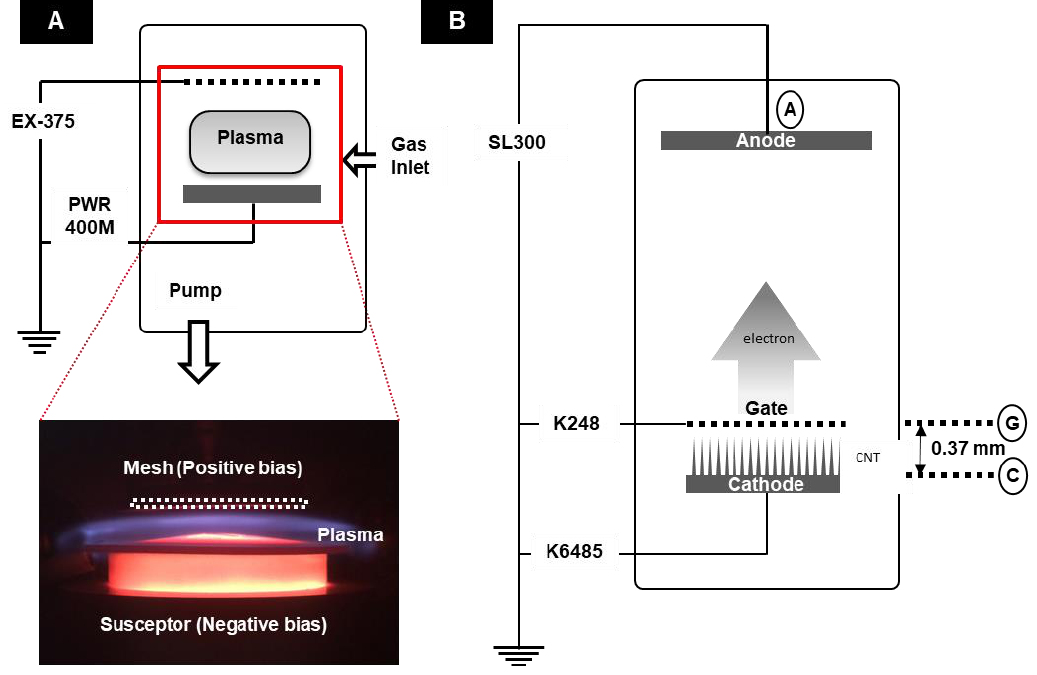
Figure 1. ( A ) Optical image and schematic diagram of plasma-enhanced chemical vapor deposition (PECVD); ( B ) Schematic diagram of field emission (FE).